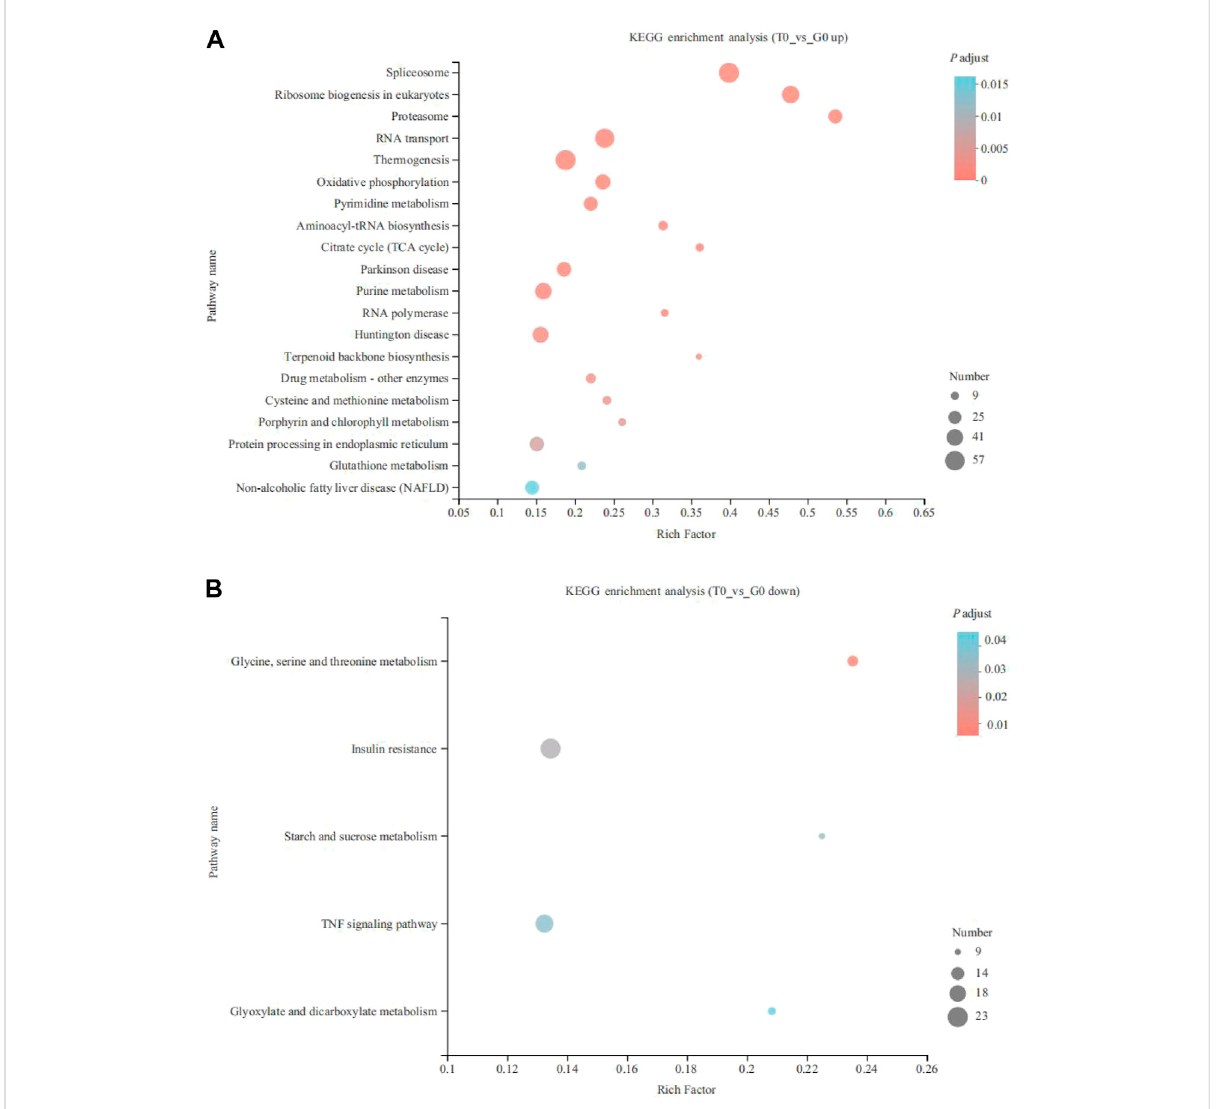
FIGURE 3 KEGG pathway enrichment analysis of the DEGs derived from the fi sh subjected to the cold stress. (A) upregulated genes. (B) downregulated